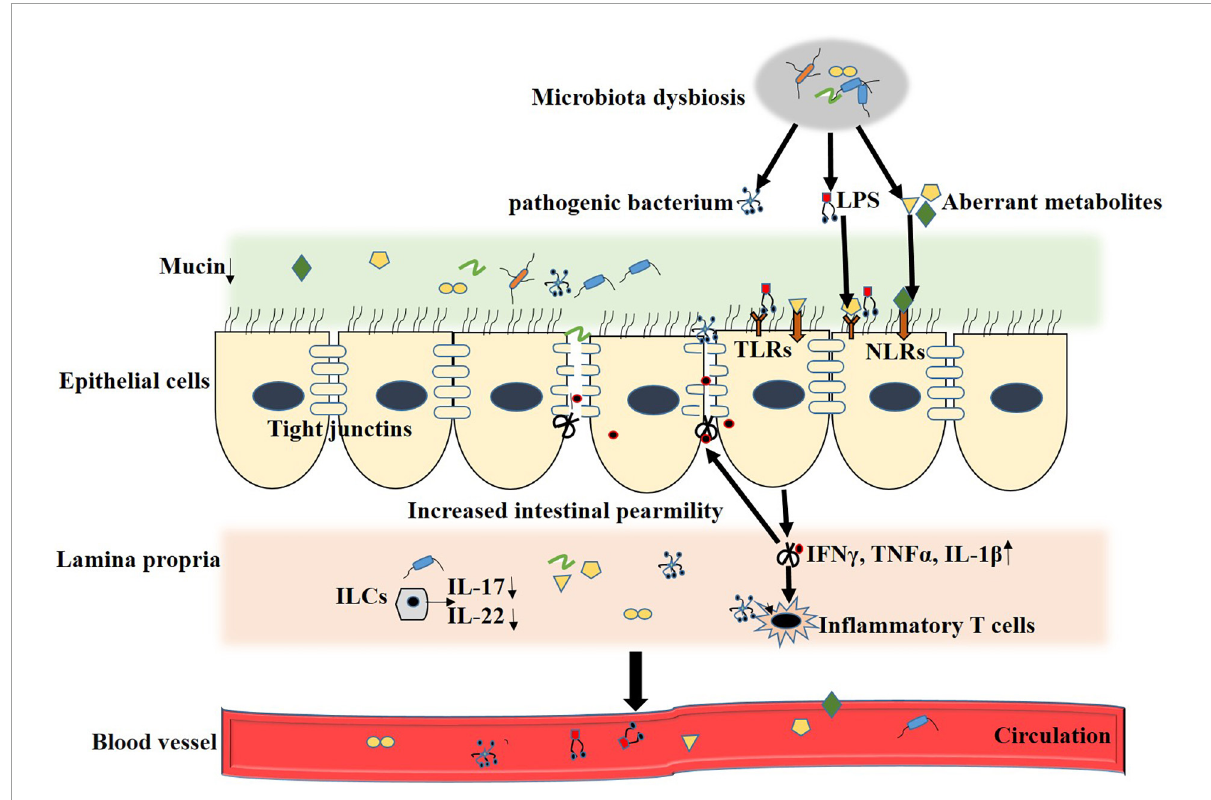
FIGURE1 Microbial metabolites regulate T2DM complication. Loss of integrity makes the gut epithelium more vulnerable to allow pathogenic bacterium and metabolites translocate into systermic circulating. Disturbed gut microbiota result in decreased systemic short-chain fatty acids (SCFA) concentrations, which, in turn, promotes inflamation and decreases glucagon-like peptide 1 (GLP-1) secretion by acting on G protein-coupled receptor (GPCRs). Elevated trimethylamine (TMA) in gut translocate to liver through the leaked intestinal barrier and is oxidized into trimethylamine N-oxide (TMAO) by Flavin containing monooxygenase3 (FMO3), which further enter into systemic circulation and contributes to insulin resistance, diabetic nephropathy and CVD. Secondary bile acids are involved in multiple hormonal regulatory by antagonizing farnesoid X receptor (FXR) and G-protein coupled bile acid receptor (TGR5) and contributed to development of diabetic retinopath and CVD. Elevated circulation of lipopolysaccharide (LPS) trigger innate immunity and construct a chronic inflammation status by activating Toll like receptors (TLRs) and NOD-like receptors (NLRs), which is the culprit of T2DM related